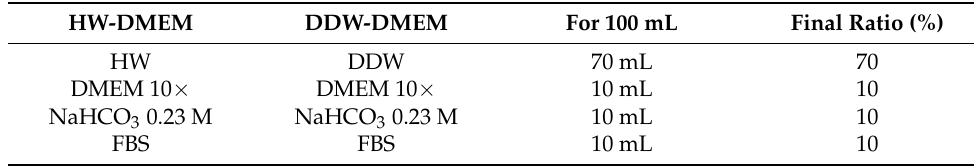
Table 2. HW-DMEM or DDW-DMEM